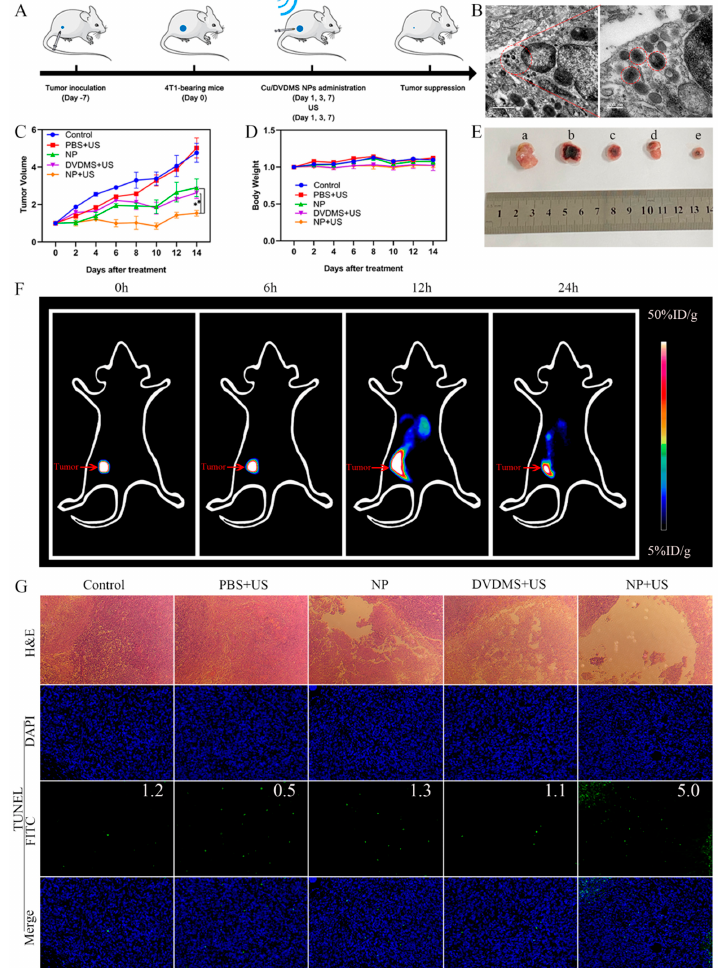
Figure 4. ( A ) In vivo therapeutic protocol of SDT on mice subcutaneous tumor mode. ( B ) TEM images of 4T1 tumor thin sections at 12 h after injection of Cu/DVDMS. ( C ) Tumor growth curves and ( D ) body weight curves of subcutaneous tumor model mice after different treatments ( n = 5, mean ± SD). ( E ) Representative tumor tissues collected, respectively, from (a) Control, (b) PBS+US, (c) NP, (d) DVDMS+US, and (e) NP+US groups at day 14. ( F ) PET images of 4T1 tumor-bearing mice at 0, 6, 12, 24 h. ( G ) H&E staining and TUNEL of tumor sections collected from different groups of mice after 14 days post-treatment, the values indicated mean intensity of FITC. * p <